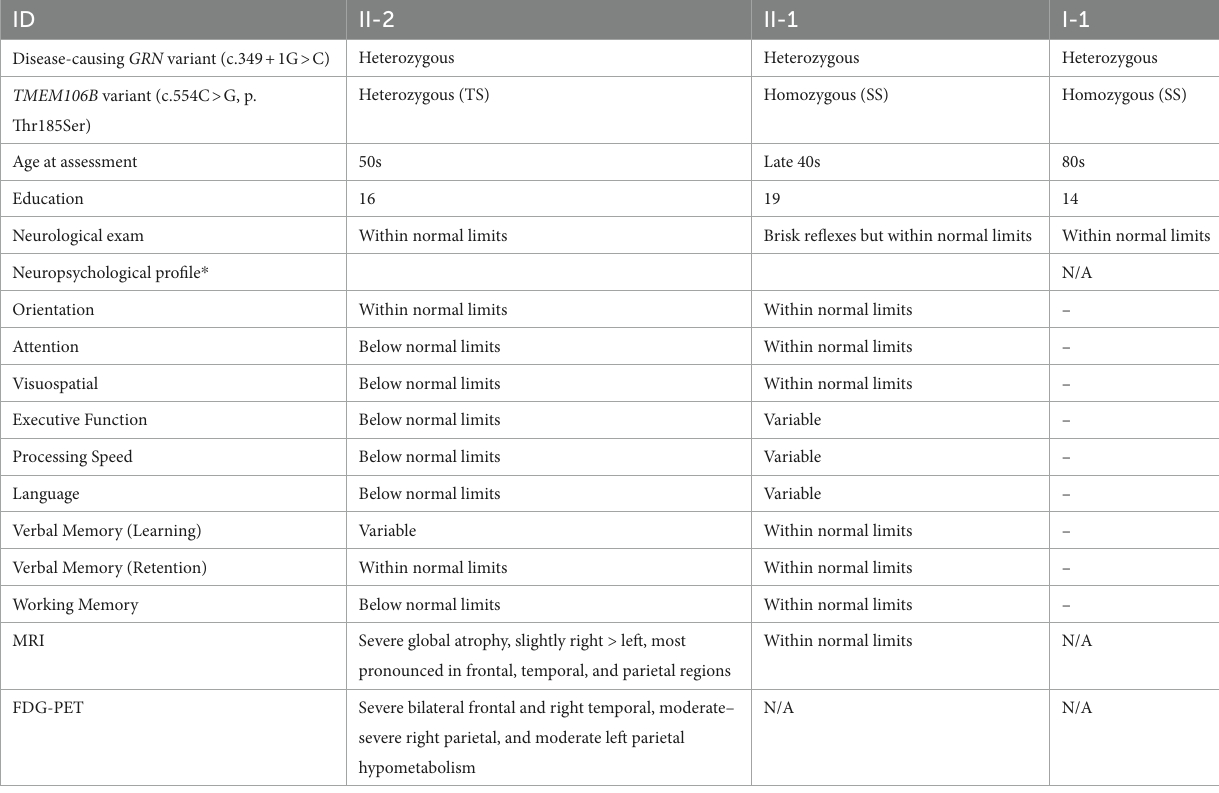
TABLE 1 Family member information and results of neurological